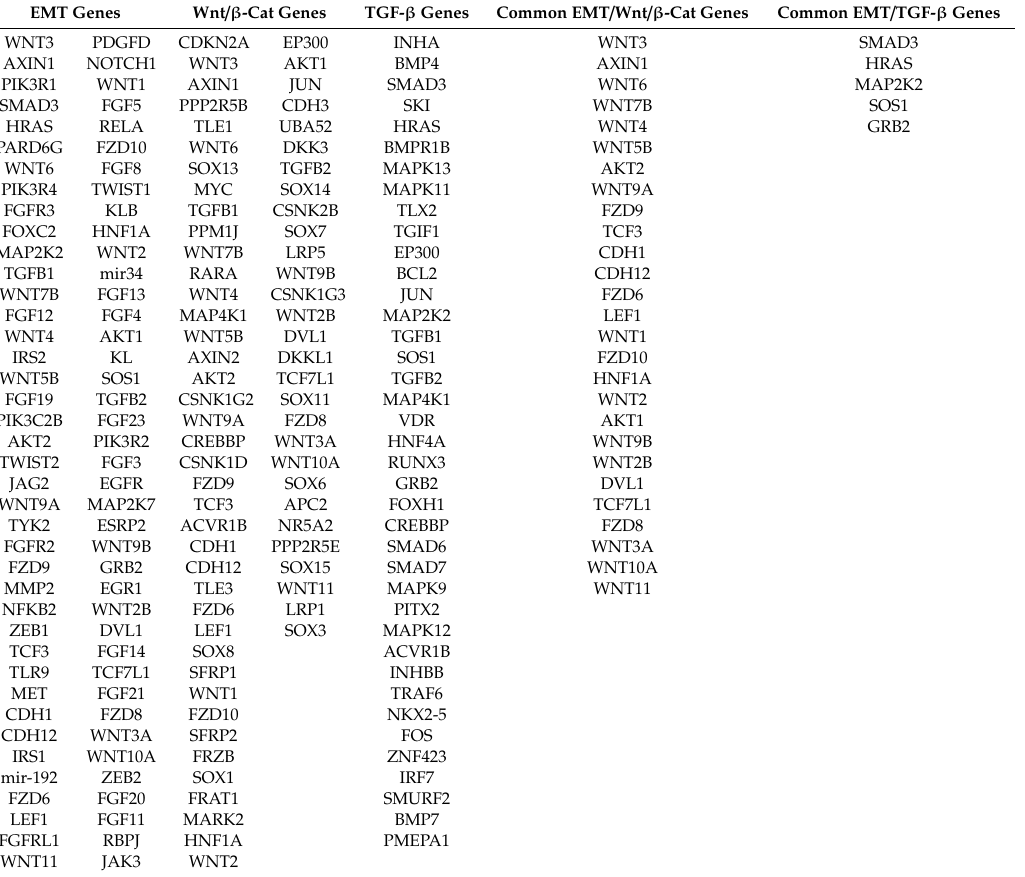
Table A1. List of genes displaying EMT-related DNA methylation alterations upon IPA analysis of the EMT, Wnt / β -cat and TGF- β canonical pathways, including common genes between EMT / Wnt / β -cat or EMT / TGF- β canonical